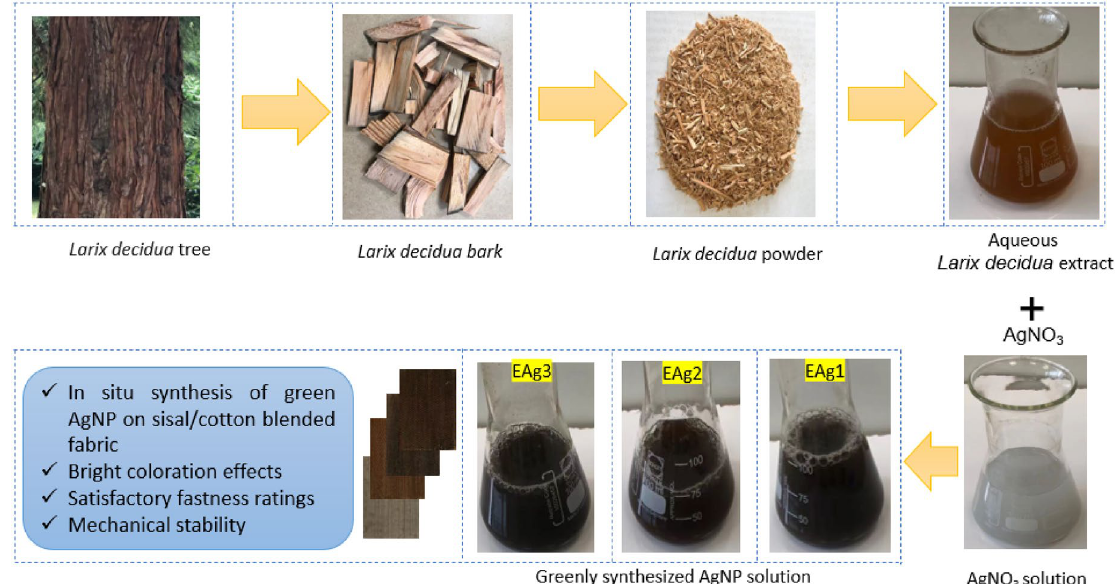
Figure 1. A schematic operational protocol for the extraction of European larch bark aqueous solution and in situ biosynthesis of nanocolloids on sisal/cotton interwoven fabrics.